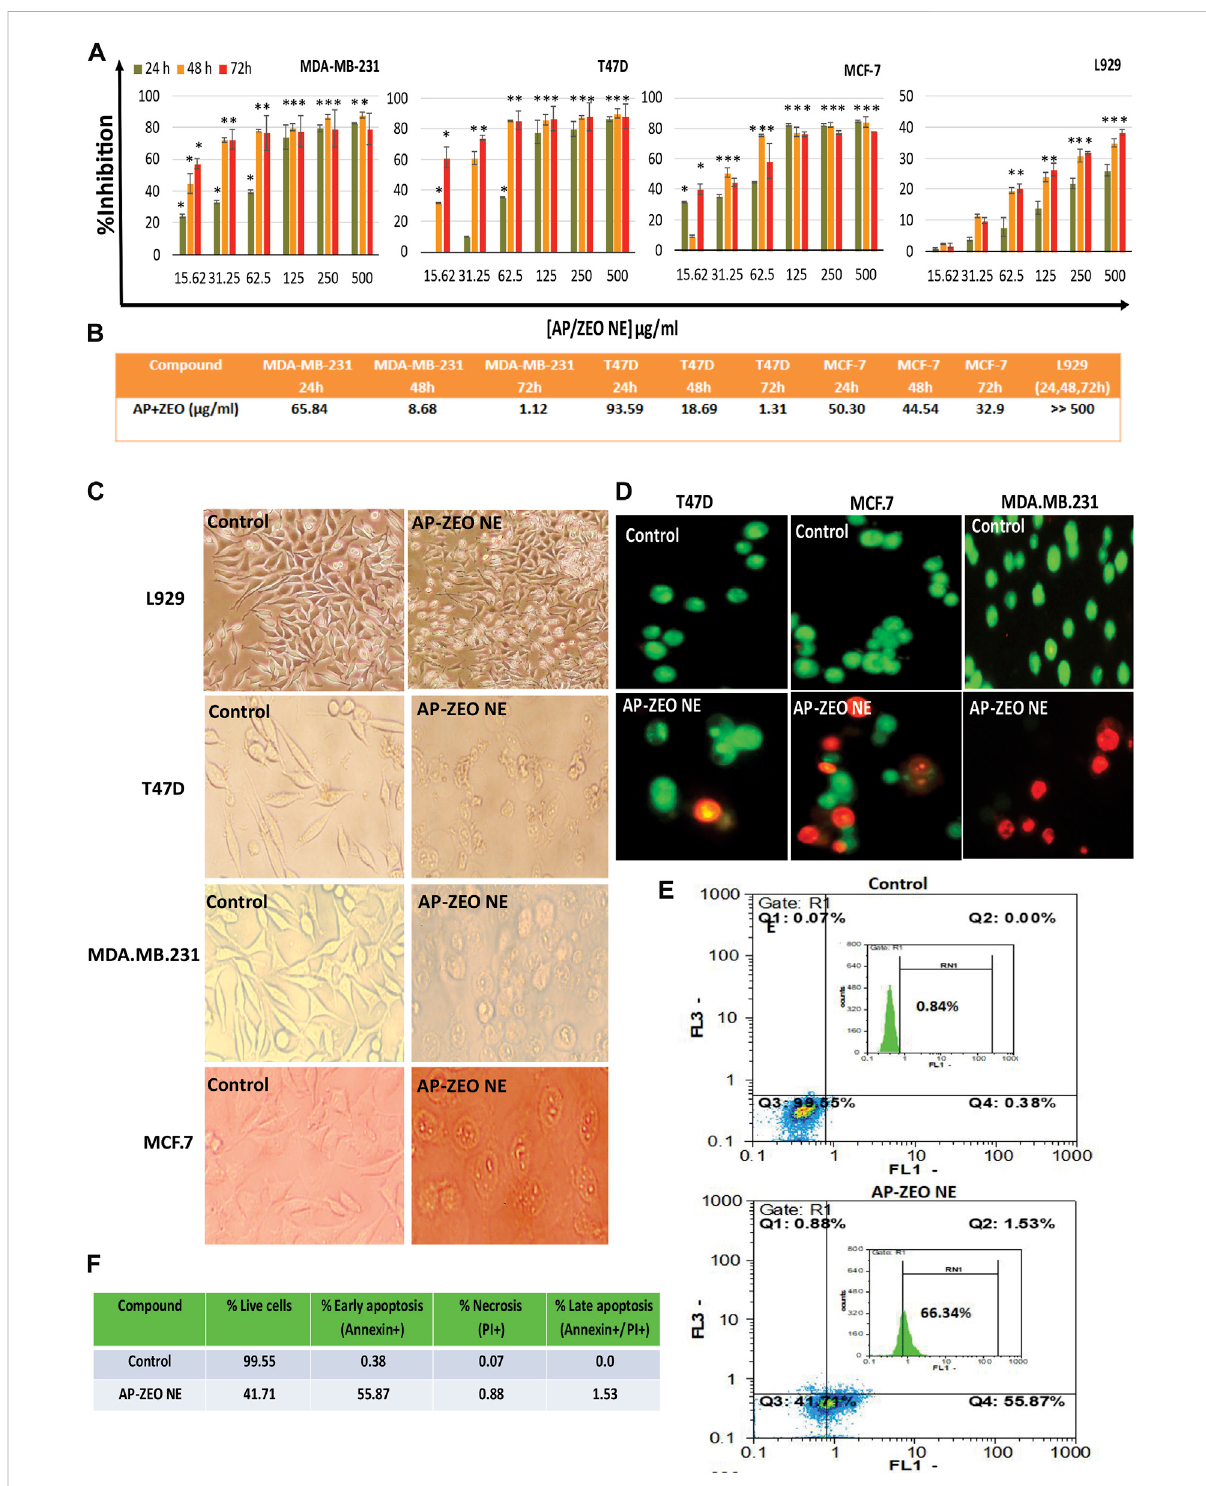
FIGURE 2 (A,B) Cytotoxicity and IC50 (µg/ml) values of AP-ZEONE against T47D, MCF-7, MDA. MB.231, and L929 cell lines. The treatment times were 24, 48, and 72 h, respectively. Apoptotic cells were observed (C) as rounded and non-adherent entities, (D) blebbing and DNA fragmentation (E,F) phosphatidylserine externalization at AP-ZEONE IC50 compared to control intact cells. The “ *** “ , “ ** “ and “ * “ indicate the level of statistical signi fi cance p < 0.001, p < 0.01 and p < 0.05,